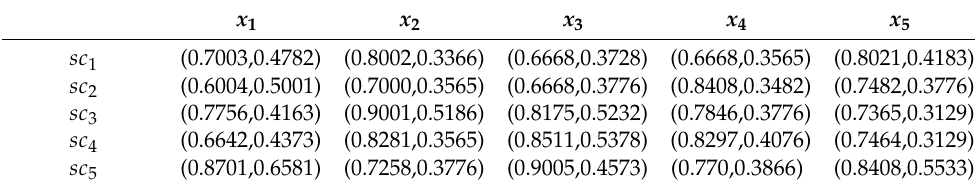
(cid:110) (cid:111) α ij .